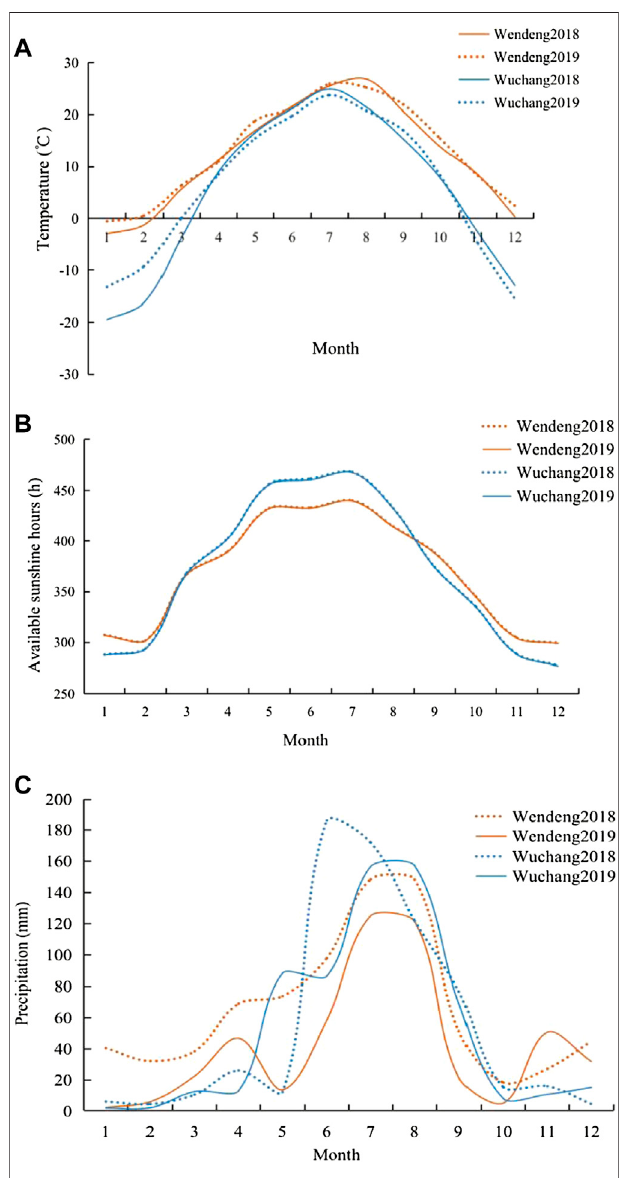
FIGURE 3 | Comparison of temperature (A) , sunshine (B) , and precipitation (C) between Wendeng and Wuchang during 2018 and 2019.